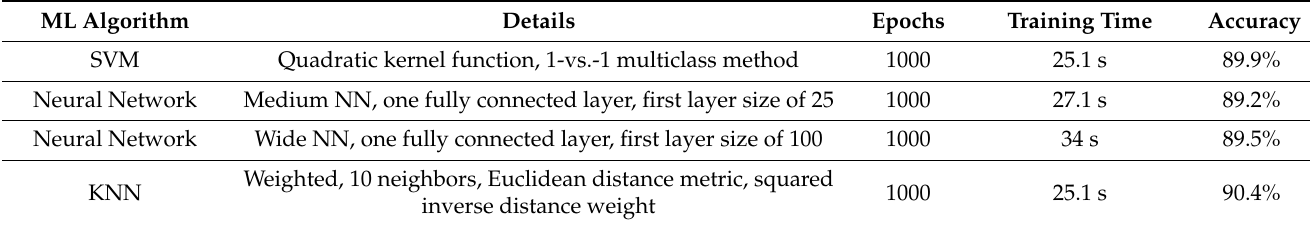
Table 4. Machine Learning Algorithm Performance Comparison.